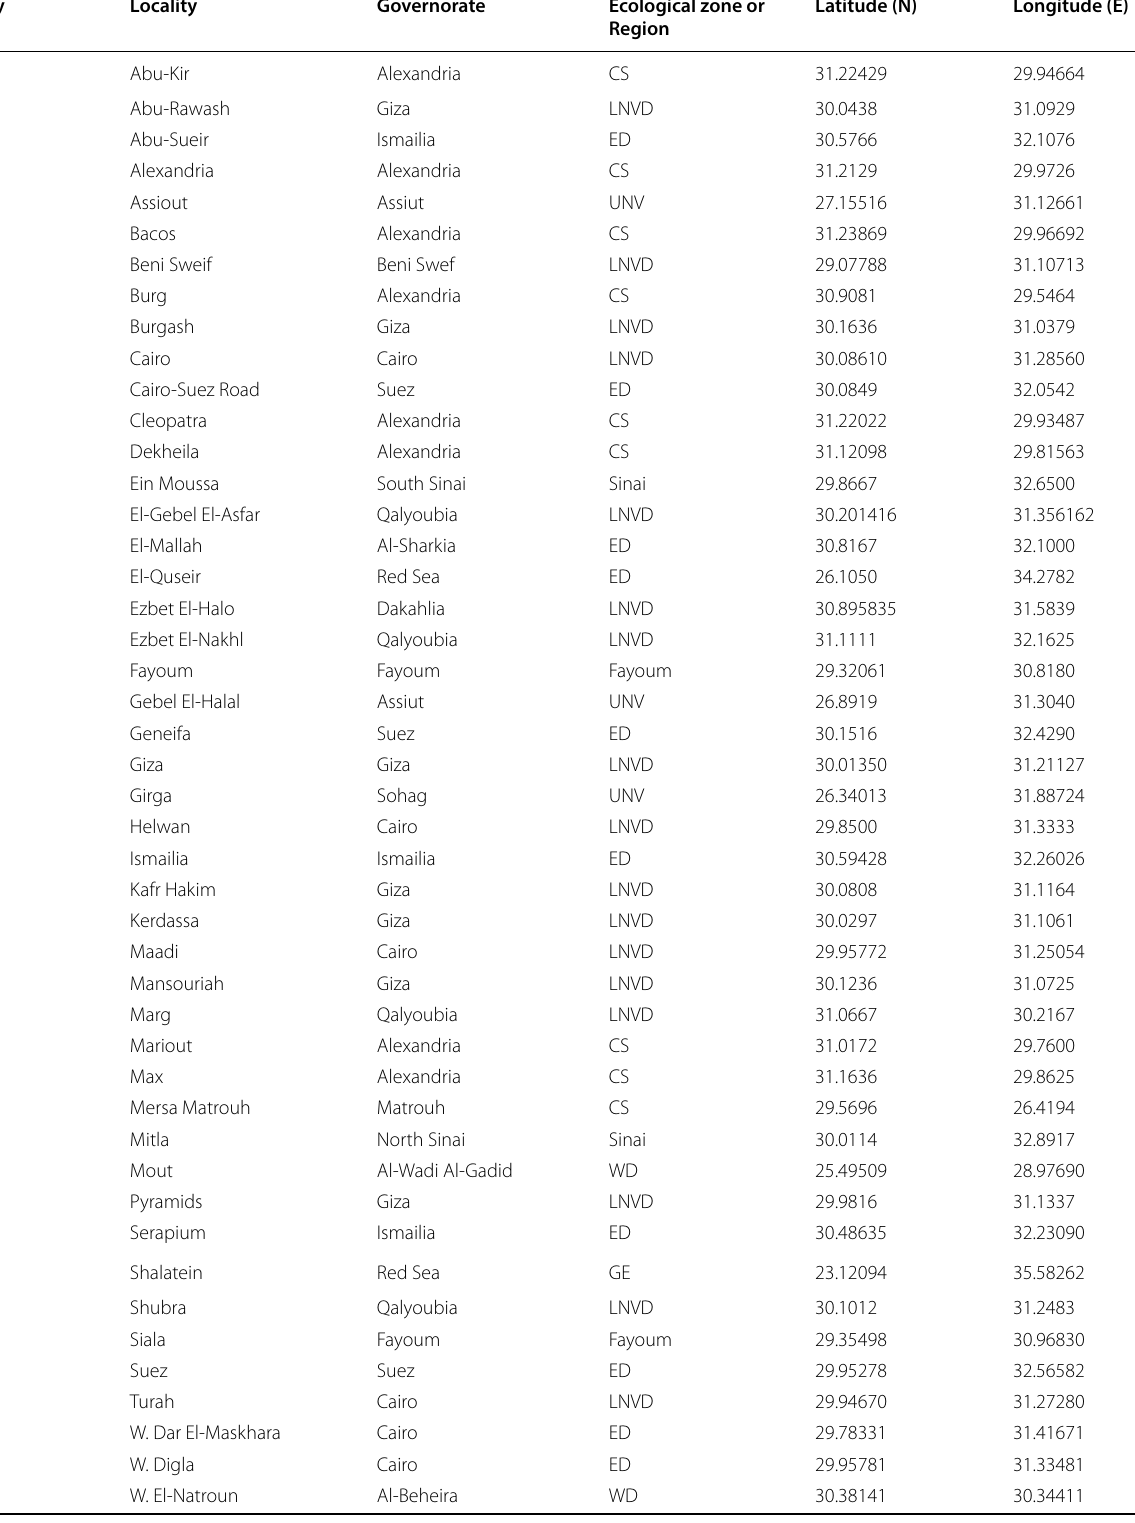
Table 2 A gazetteer of nemestrinid localities in Egypt and Saudi Arabia